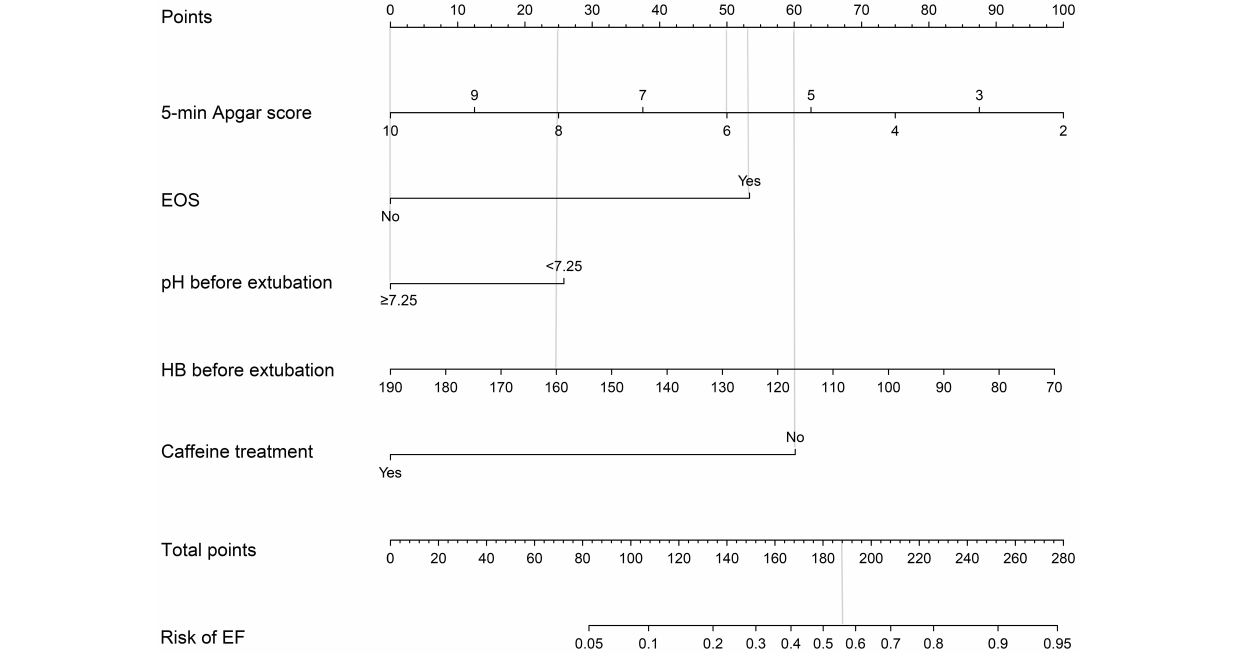
FIGURE 2 | Extubation failure risk nomogram. The extubation failure risk nomogram was developed in the cohort, with 5-min Apgar score, the dignosis of EOS, pH before extubation, HB before extubation, and the caffeine treatment. To estimate the probability of extubation failure, mark infant values at each axis, draw a straight line perpendicular to the point axis, and sum the points for all variables. Next, mark the sum on the total point axis and draw a straight line perpendicular to the probability axis. EOS, early-onset sepsis; HB, hemoglobin concentration; EF, extubation